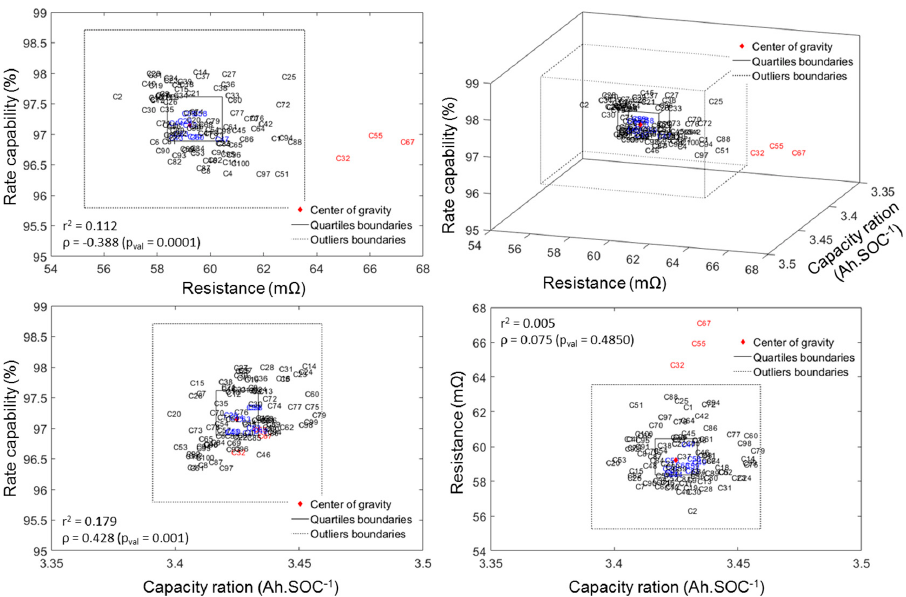
Figure 5. 3D map and top/side/front projections of the measured rate capability, capacity ration and ohmic resistance highlighting cell-to-cell variations.